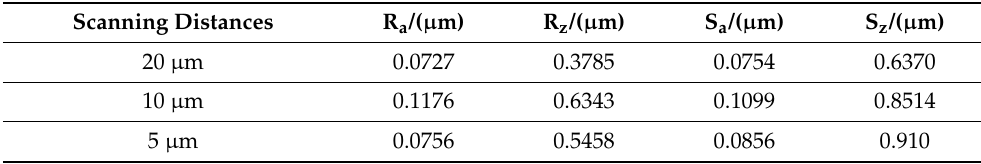
Figure 9. Glare phenomenon in automobile display equipment and anti-glare tests of laser textured samples. ( a ) glare phenomenon, ( b ) strong indoor light, and ( c ) anti-glare testing. The line roughness R a and R z , as well as the surface roughness S a and S z , are used to evaluate the roughness of the surfaces, as shown in Table 1. The line roughness of the three samples met R a 0.1 and R z 0.8, reaching the N3 standard with a high degree of surface smoothness. The values of Sa and R a are close to each other, and S z is slightly larger than R z , indicating a high degree of uniformity in all directions of the sample surface and a small surface irregularity defect. This indicates that the laser-textured glass can maintain a high degree of surface smoothness. Table 1. Roughness of samples with different scanning distances.